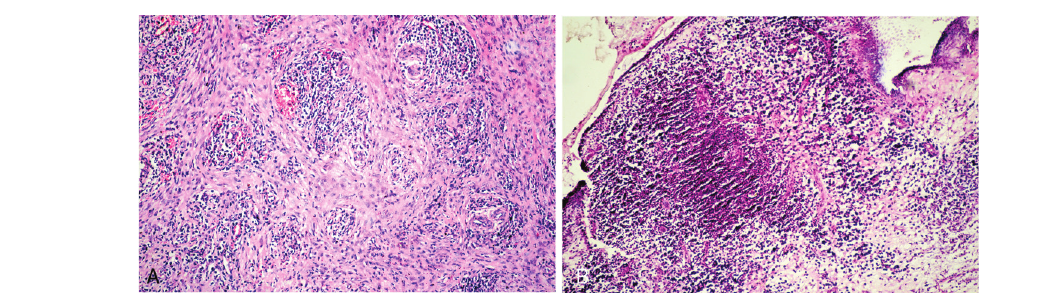
Cholesteaoma in (left) adult group and (right) pediatric group. Note the higher grade of fibrosis in the adult group as compared to the pediatric case as well as the greater intensity of the inflammatory Cellular infiltration in the pediatric case as compared to the adult case (H & E,